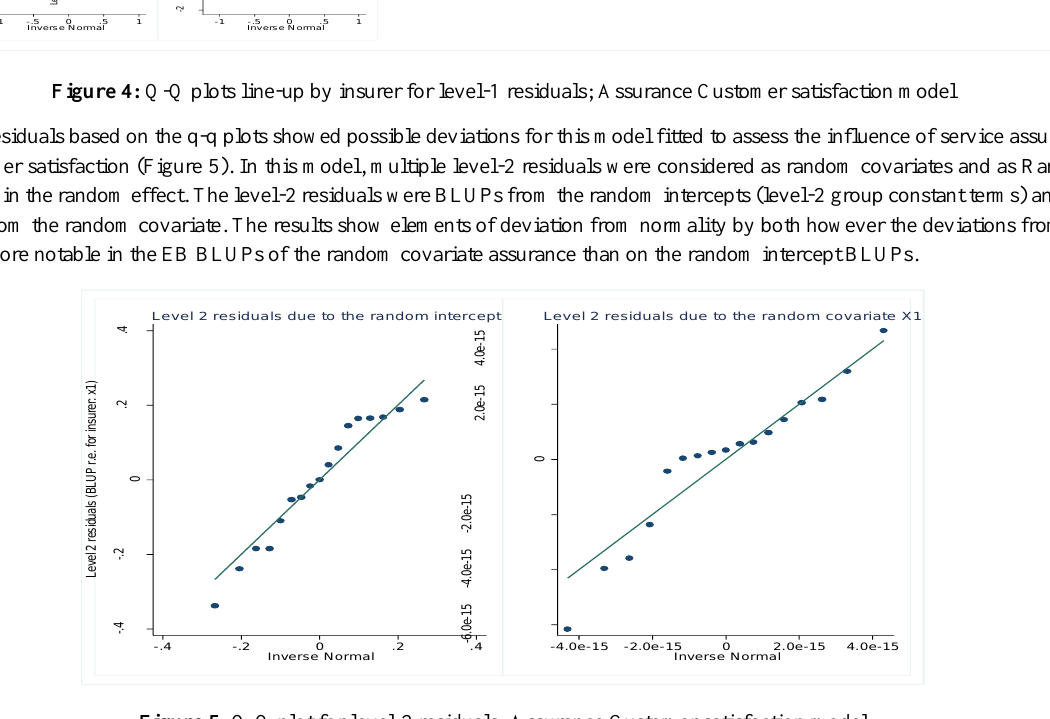
Figure 5 : Q-Q plot for level-2 residuals; Assurance Customer satisfaction model The hanging rootogram confirmed the deviation from normality in the level-2 residuals of this model (Figure 6). From the residuals due to the random intercepts, only one hanging root has the 95% confidence interval away from the theoretical distribution. For the residuals due to assurance as a covariate, most of the hanging roots were significantly lower or higher than the theoretical normal distribution line (Zero).